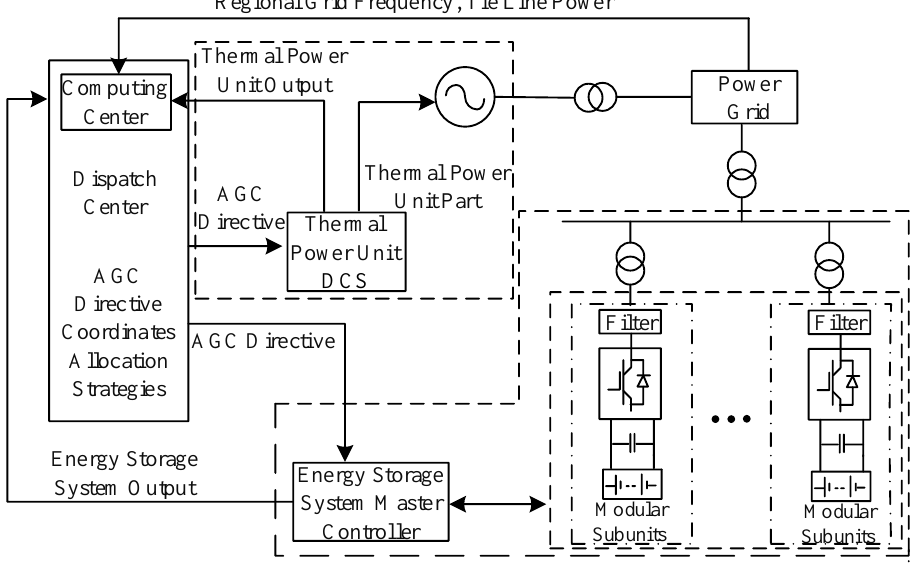
Figure A1. Schematic diagram of coordinated control of thermal power and energy storage.